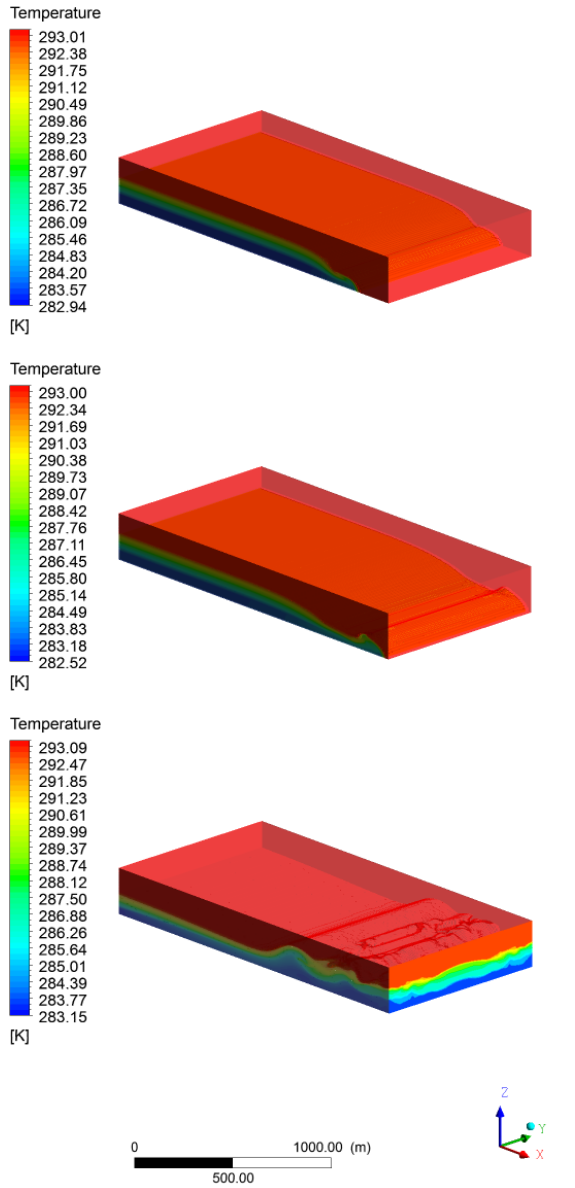
Figure 11. Evolution of internal wave simulation in the model temperature field (in Kelvin). Time evolution is from top to bottom. Top: after time 200 s, middle: after 400 s, bottom: after 1800 s.